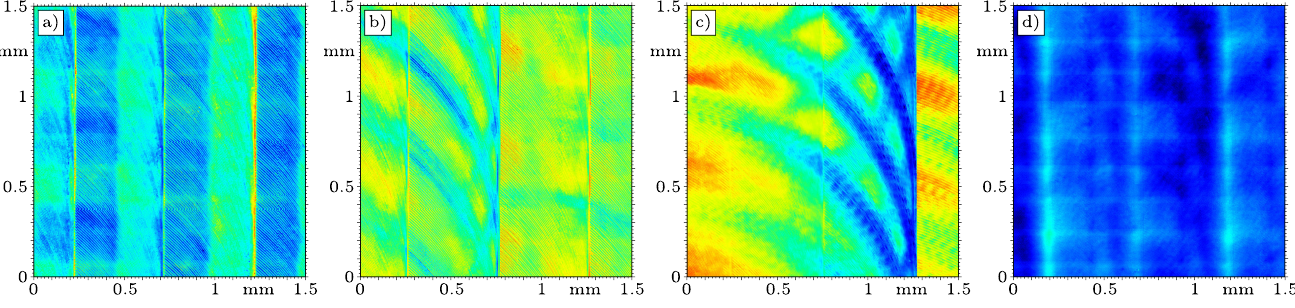
45 ◦ -1 ◦ , ( b ) R0.05-2 ◦ , ( c ) R0.05-0 ◦ ×